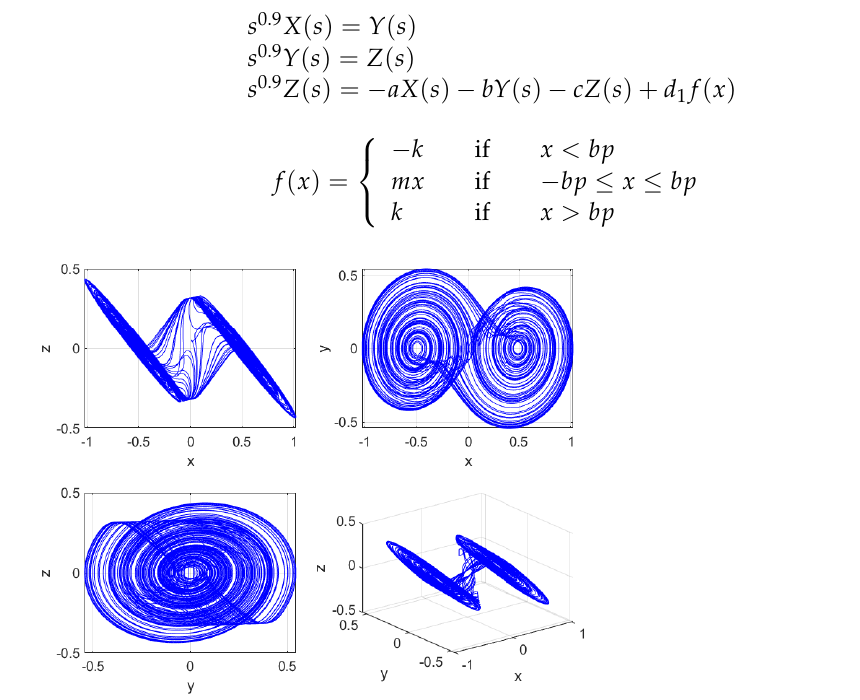
Figure 2. Portraits of the chaotic attractors of FOCO 2 given by (5). Each plot shows the attractor among two or three state variables x , y , z